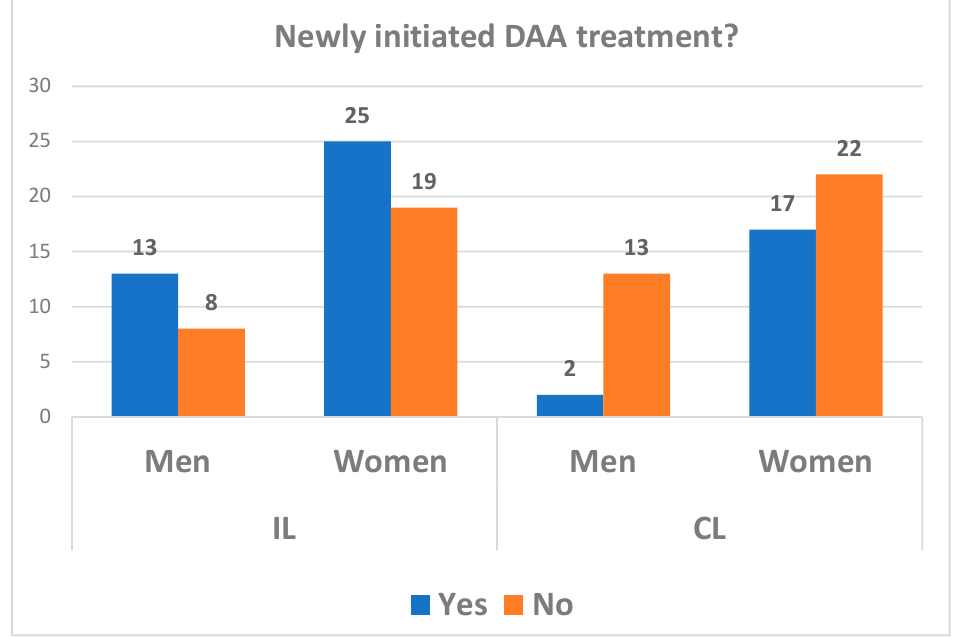
Figure 3. Comparative view of DAA treatments initiated versus cases in which antiviral treatment could not be initiated.